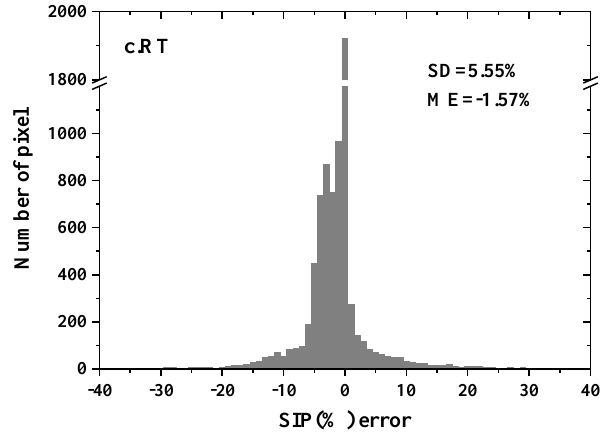
Figure 12. The SIP estimation error histogram based on the differences between the reference SIP and the estimated SIP using LSU ( a ), ANN ( b ) and RT ( c ) methods. SD and ME represent the standard deviation and mean value of the SIP error, respectively.